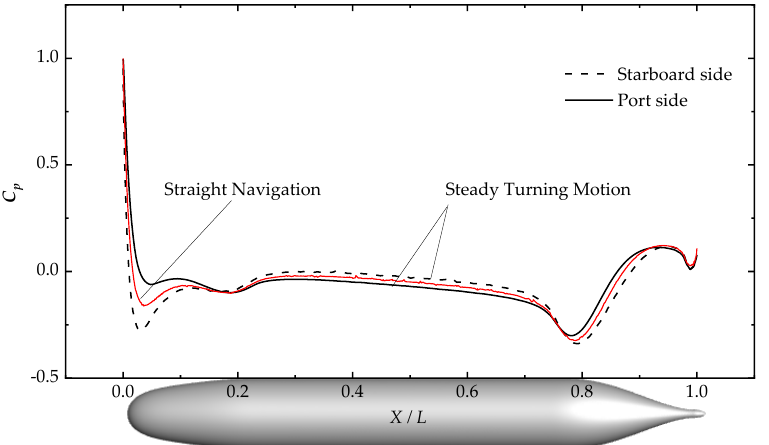
Figure 10. Pressure coefficients along the meridians of the port side and starboard side for different motion types.